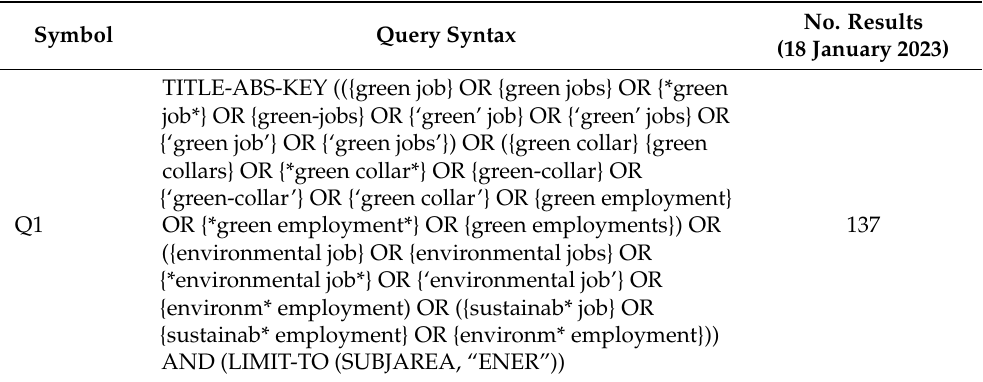
Table 2. Search Query syntax details. Each publication title is indexed in the Scopus database. Asterisk is a Boolean operator in this